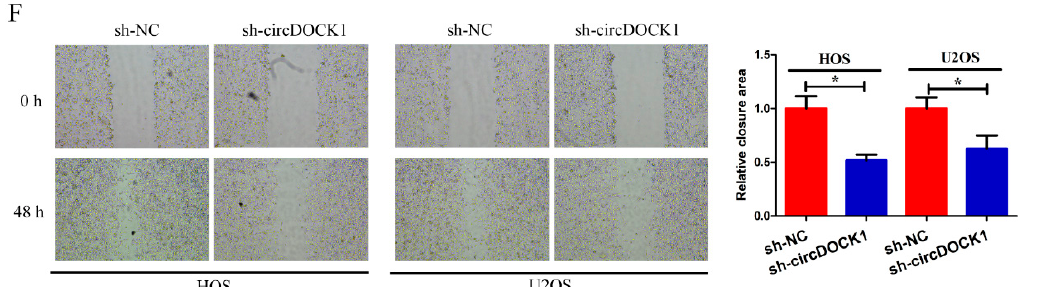
Figure 2. CircDOCK1 knockdown inhibits OS progression in vitro. ( A ) CircDOCK1 expression was detected in transfected OS cells. ( B , C ) CCK-8 plus EdU assay outcomes for cellular proliferative potential. ( D ) Colony formation efficiency was detected in transfected OS cells. ( E , F ) Wound-healing and Transwell assay outcomes for cellular motility and invasion. * p < 0.05, ** p < 0.01.